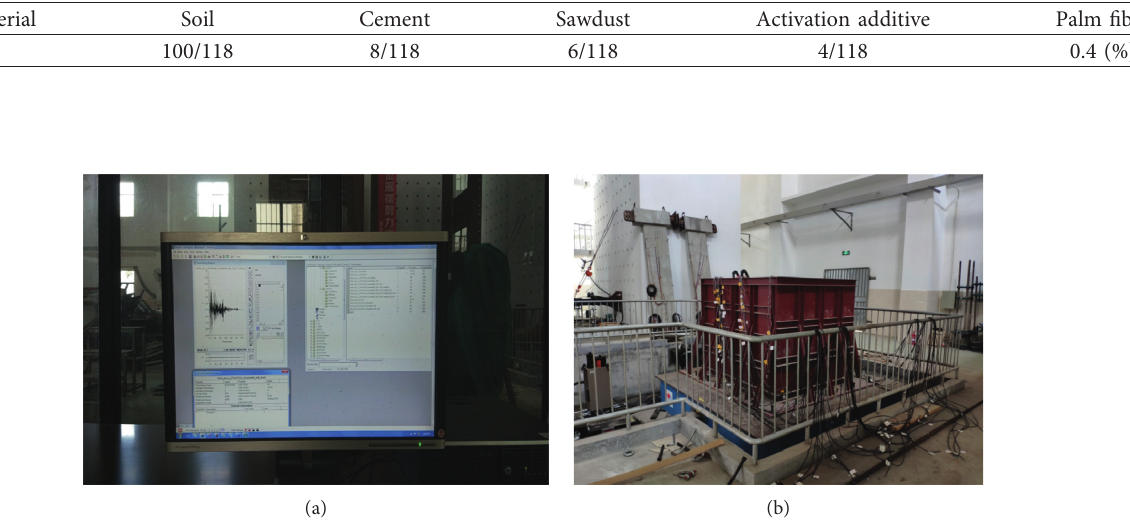
Figure 4: Data acquisition system and rigid box for the shaking table